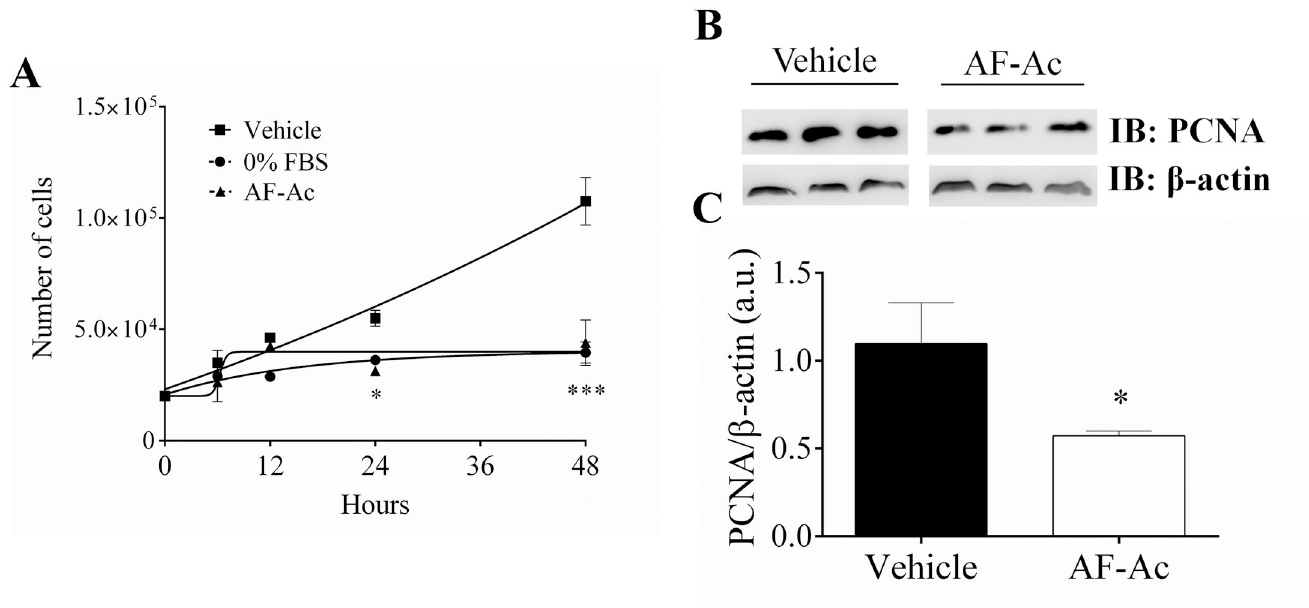
Fig 5. Cell growth assay of HepG2 cells at 6, 12, 24 and 48 h after stimulation with 50 μ g/mL AF-Ac or vehicle (control, cells treated with DMEM medium containing 0.05% DMSO), triplicate in 3 individual experiments (A). Representative immunoblotting of total HepG2 cell lysates probed with anti-PCNA and anti- β - actin, used as protein loading control (B). Immunoblotting densitometry analysis. Results show β -actin normalized proteins expression (n = 3 individual experiments/group) (C). Values are expressed as mean ± SD. Significance levels are indicated by � p < 0.05 (unpaired t-test) and ��� p < 0.001 (two-way ANOVA followed by Bonferroni’s post hoc test) when compared to the vehicle group. Each protein was analyzed in cropped membranes of different Western blots along with other proteins. Full-length blots are presented in S1 Raw images.